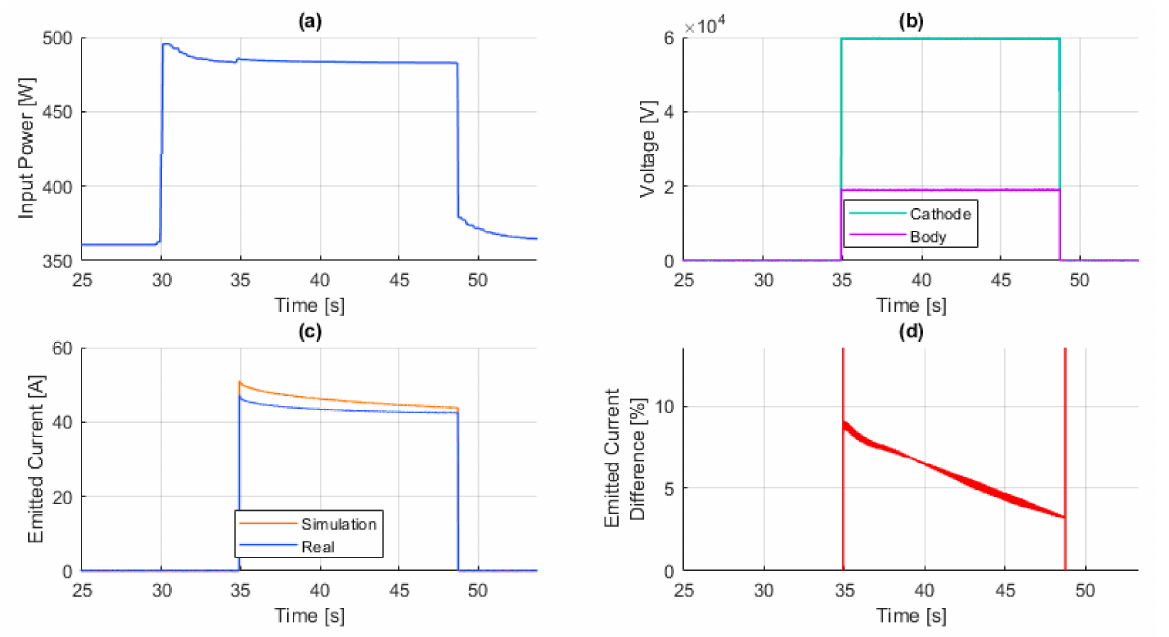
Figure 14. Shot 6679, comparison between the lumped model and experimental results: ( a ) input sequence of heating power, ( b ) input sequence of accelerating voltage, ( c ) comparison between the experimental and simulated time evolution of beam current, and ( d ) percentual error between the two.